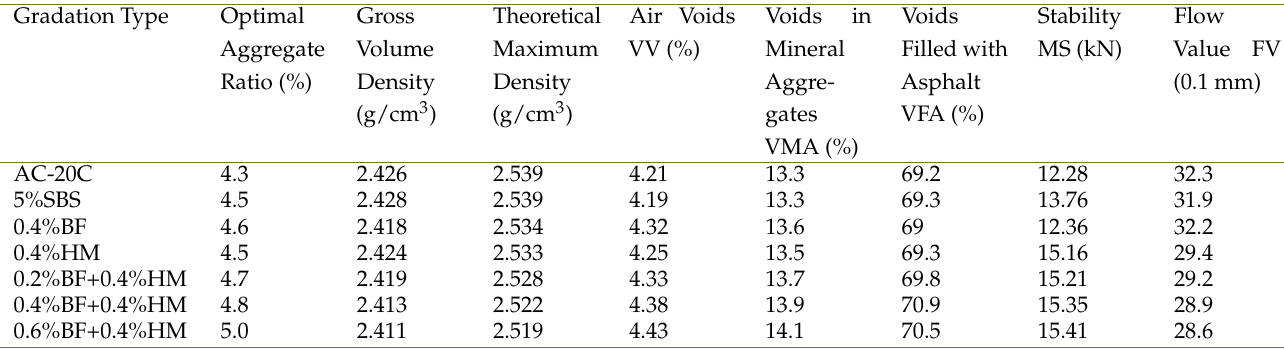
Table 4. Marshall test results of different asphalt mixtures